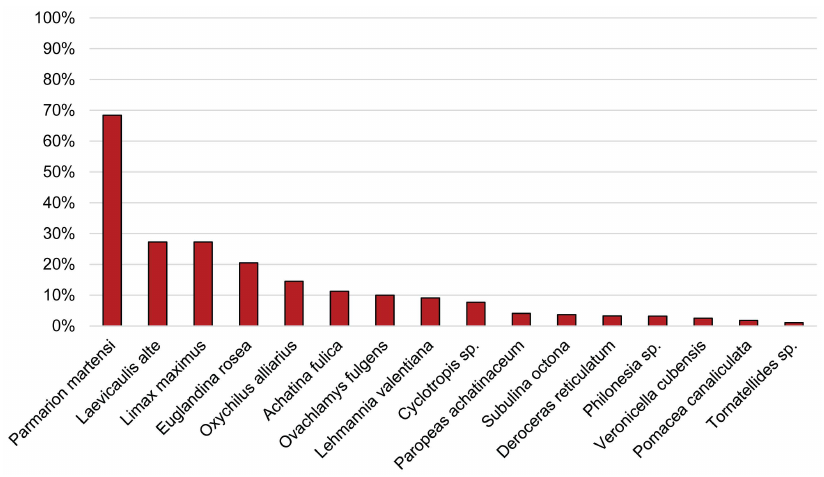
Figure 2. Infection rates for gastropod species that tested positive in this study. Levels of infection vary considerably from 68% infection in Parmarion martensi to 1% in Tornatellides sp.